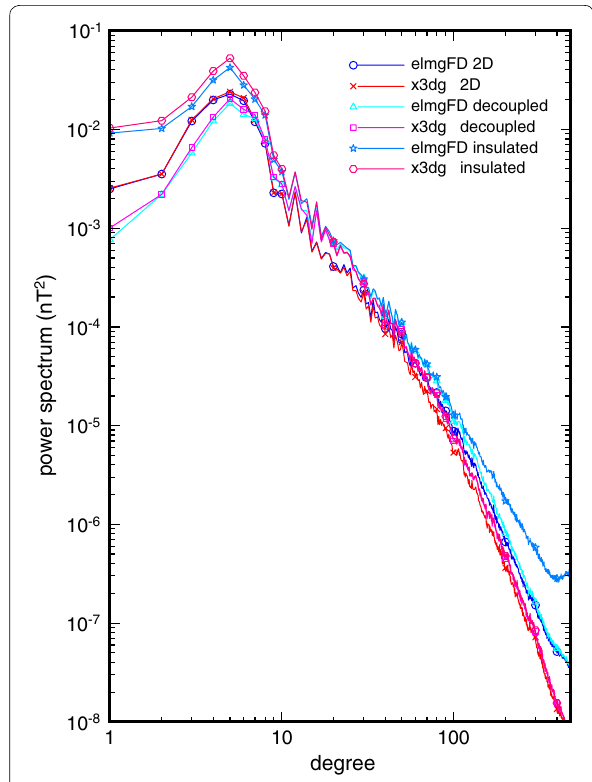
Fig. 8 Effect of physical approximations on the geomagnetic power spectra. Geomagnetic power spectra calculated at the Earth surface by the 2-D approaches elmgFD and x3dg , and the respective effects of galvanically decoupled and insulated mantle. The lateral resolution was kept at j max = 480 and 0.25 ◦ × 0.25 ◦ ,